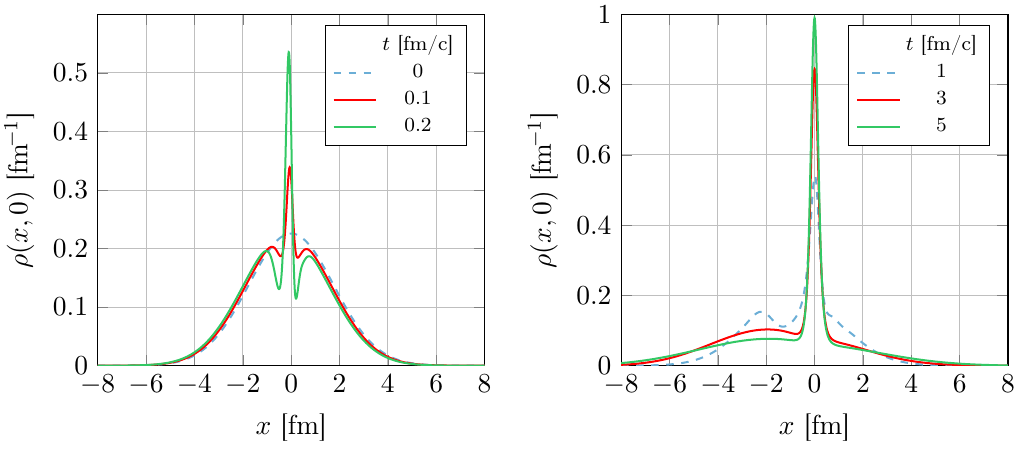
Figure 8 . Time evolution of the diagonal elements of the density matrix for the thermal scattering state de(cid:12)ned before, propagating through a bath with l env = 0 : 25 fm. It is clear that positivity is preserved by the Lindblad equation. The asymmetry of (cid:26) ( t; x; 0) for t > 0 comes from the negative momentum of the state at t = 0 , which drives the expectation value of the position ^ x towards negative values. Notice the di(cid:11)erent vertical scales in the two